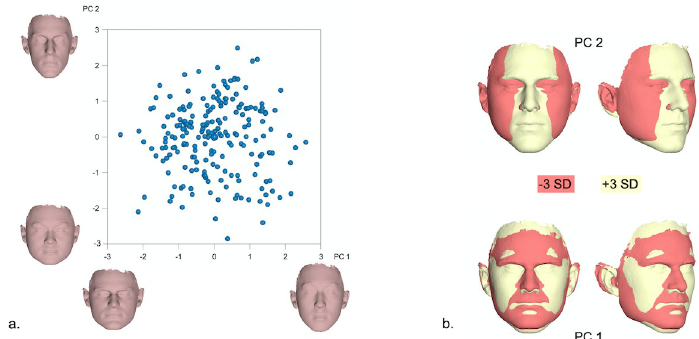
Fig 5. a. PCA graph displaying facial shape variation in males (in SD units), as explained by PC1 (20%) and PC2 (16.8%). The corresponding 3D facial morphings show the shape extremes from -3 to +3 standard deviations of PC scores within each axis. b. Best fit superimpositions of shape transformations created from the Procrustes coordinates corresponding to -3SD and +3SD of PC scores within each axis from the average shape configuration in the male population. The superimpositions display the direction of shape variation explained by each